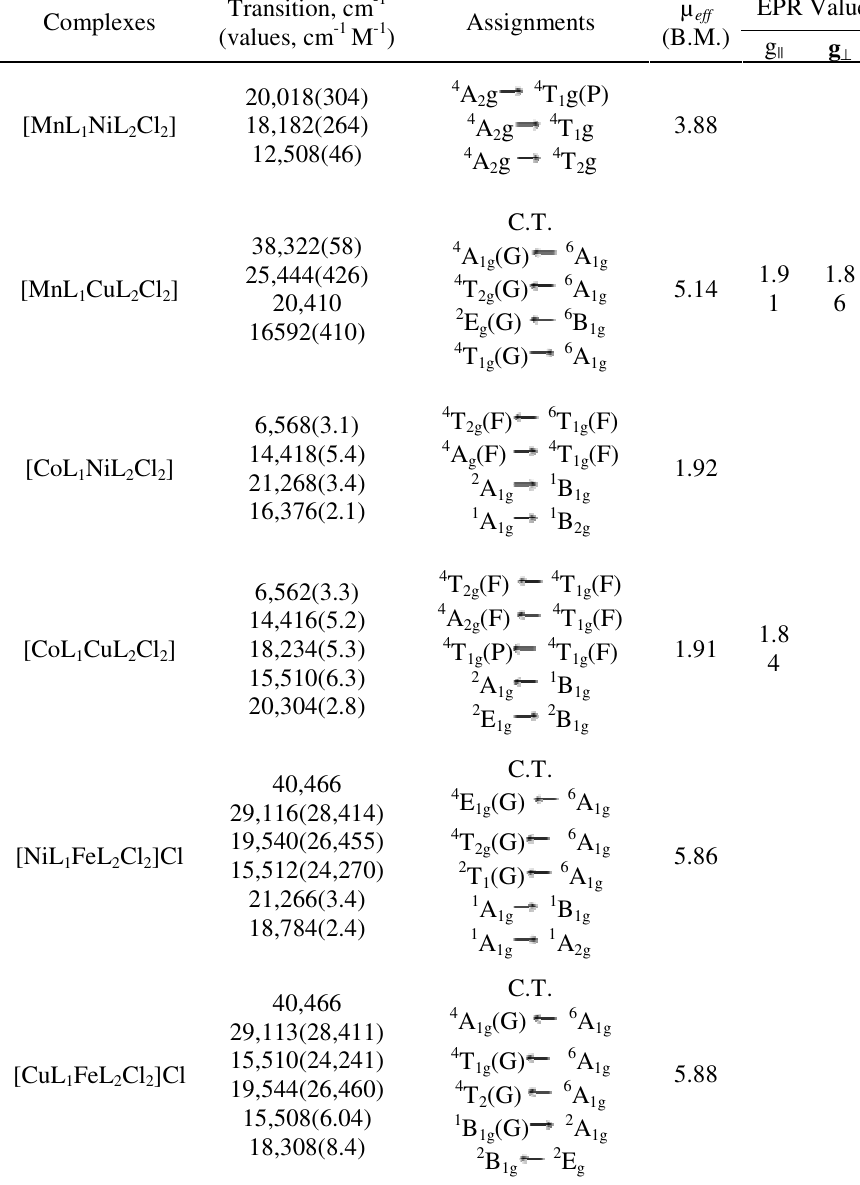
Table 3. Electronic spectra, magnetic moment and EPR data of heterobinuclear